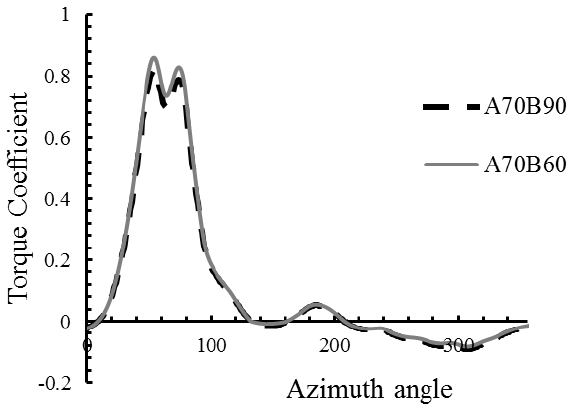
Figure 18. Torque coefficient of a single blade.